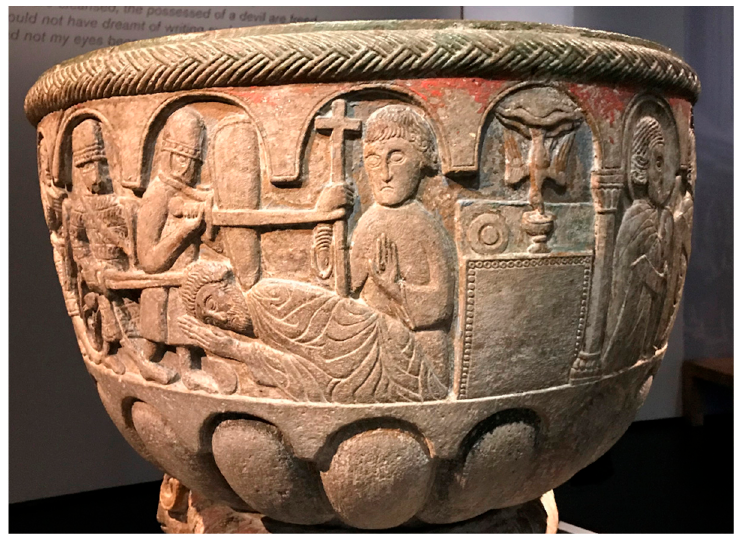
Figure 1. Baptismal font from Lyngsjö Church, Sweden. Detail of the martyrdom of Thomas Becket. Limestone. Height 785 mm. Width (bowl) 690 mm. © the Author.